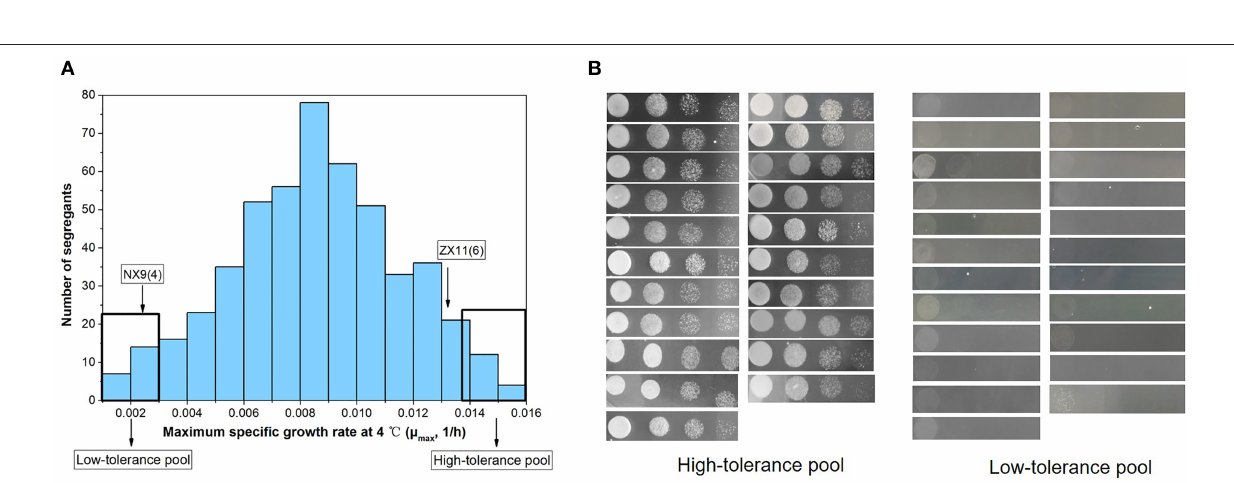
Frontiers in Microbiology | www.frontiersin.org